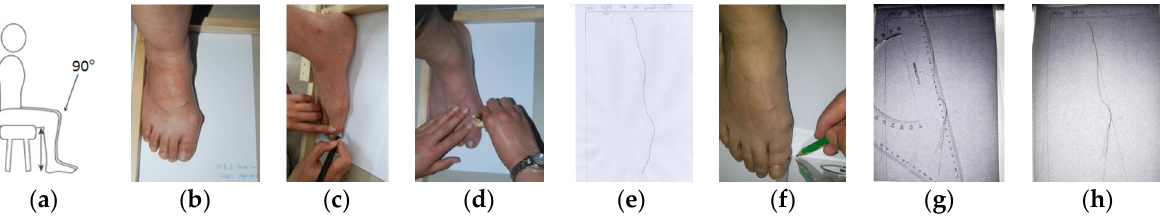
Figure 2. Design and characteristics of a newly designed measurement device.